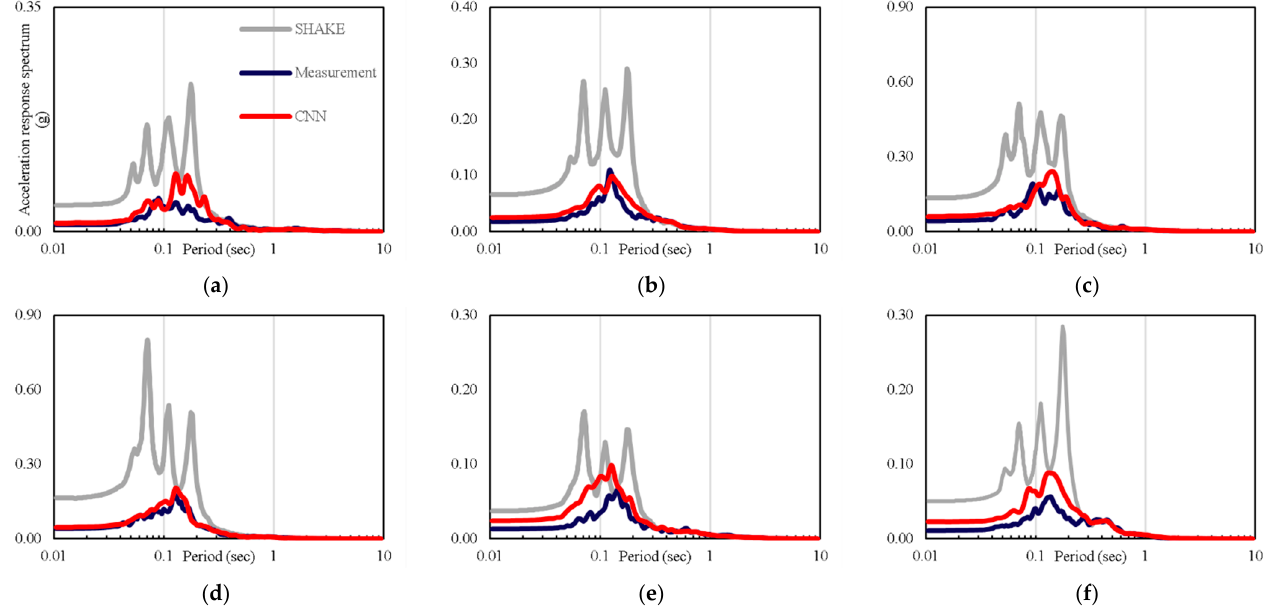
Figure 19. The six samples of acceleration response spectra measurements and predictions at site IWTH22. ( a ) IWTH221611220559.EW. ( b ) IWTH221709270522.NS. ( c ) IWTH222004200539.EW. ( d ) IWTH222004200539.NS. ( e )